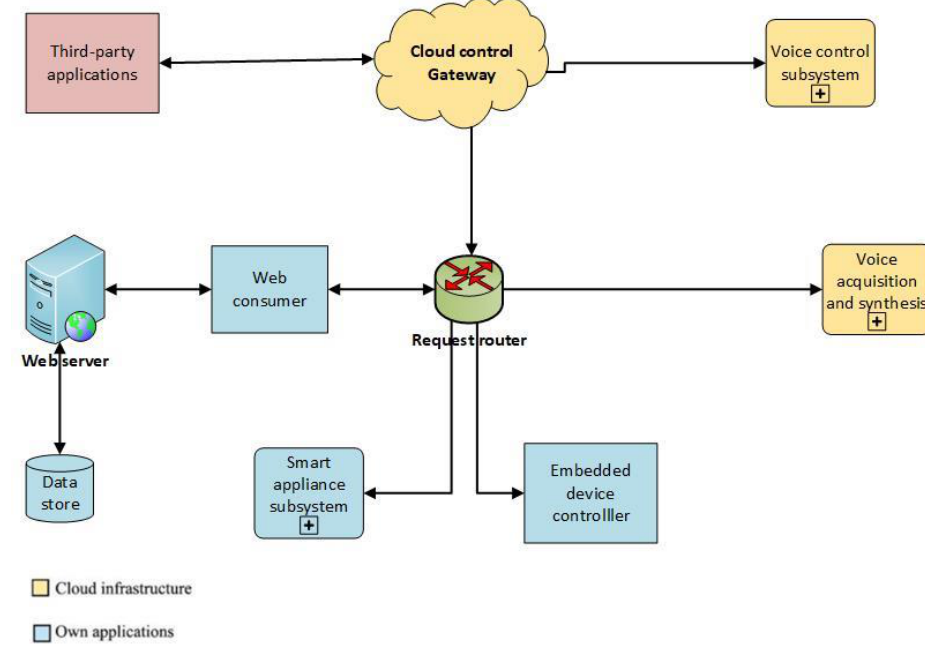
Figure 2. General framework architecture.